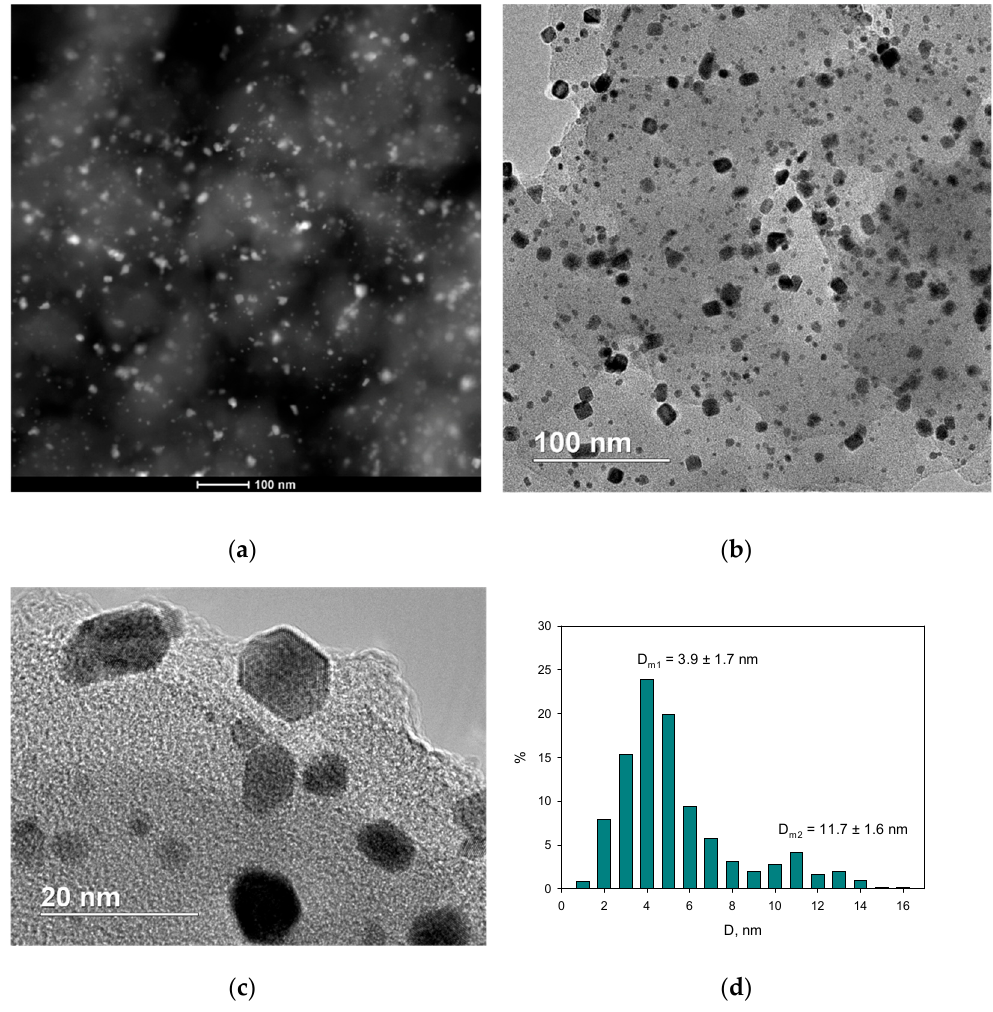
Figure 2. High-Angle Annular Dark Field Scanning Transmission Electron Microscopy (HAADF STEM) image ( a ), bright-field Transmission Electron Microscopy (TEM) images ( b , c ) and histogram of NPs size-distribution ( d ) of Pt / HAP (reduced for 3 h in hydrogen flow at 300 °C).